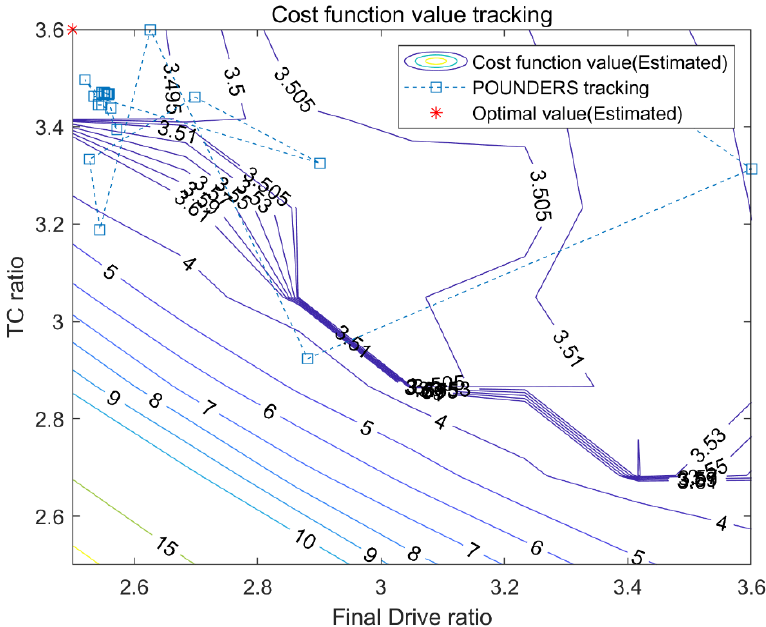
Figure 11. Cost function value contour and parameter optimization history for FD and TC. Table 6. Acceleration performance for Case